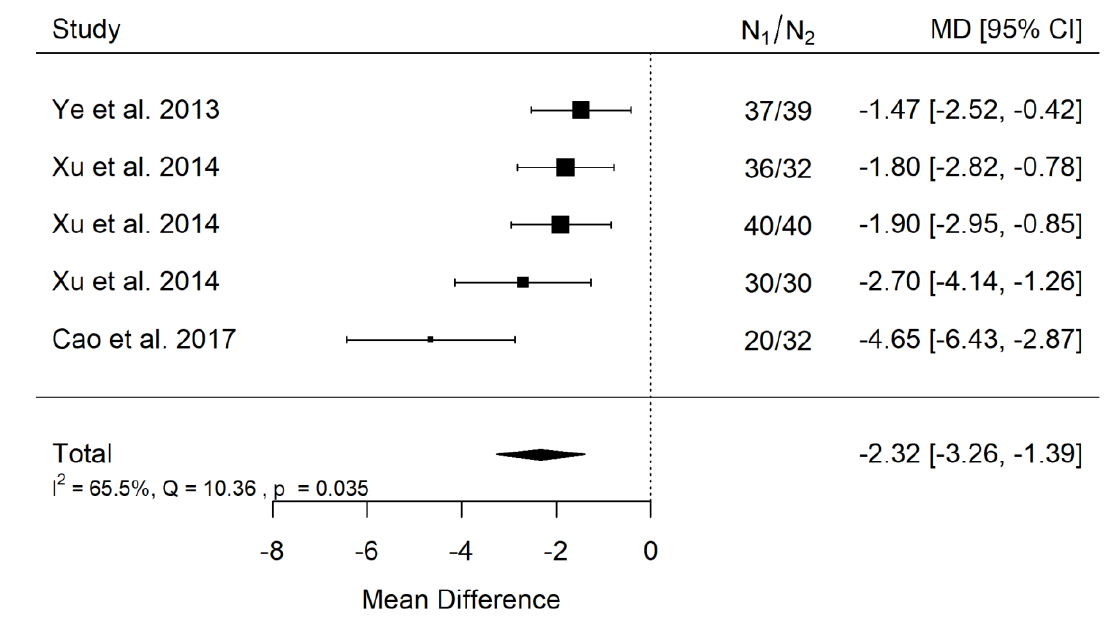
Figure 4. Forest plot of ANB values for the comparison of patients with untreated cleft palate only vs. non-cleft healthy population [18,34,35].